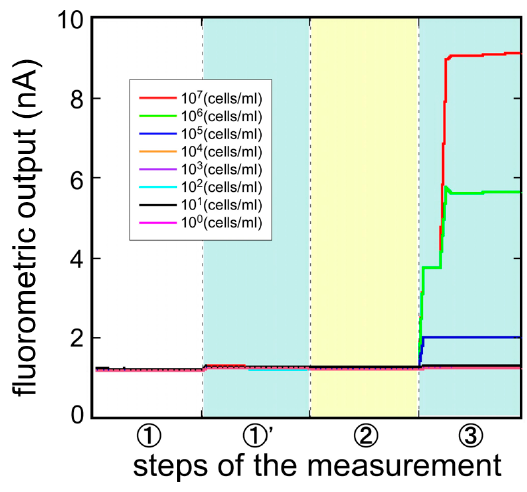
Figure 4. Typical responses of the immunosensor to varying concentrations of E. coli O157:H7.